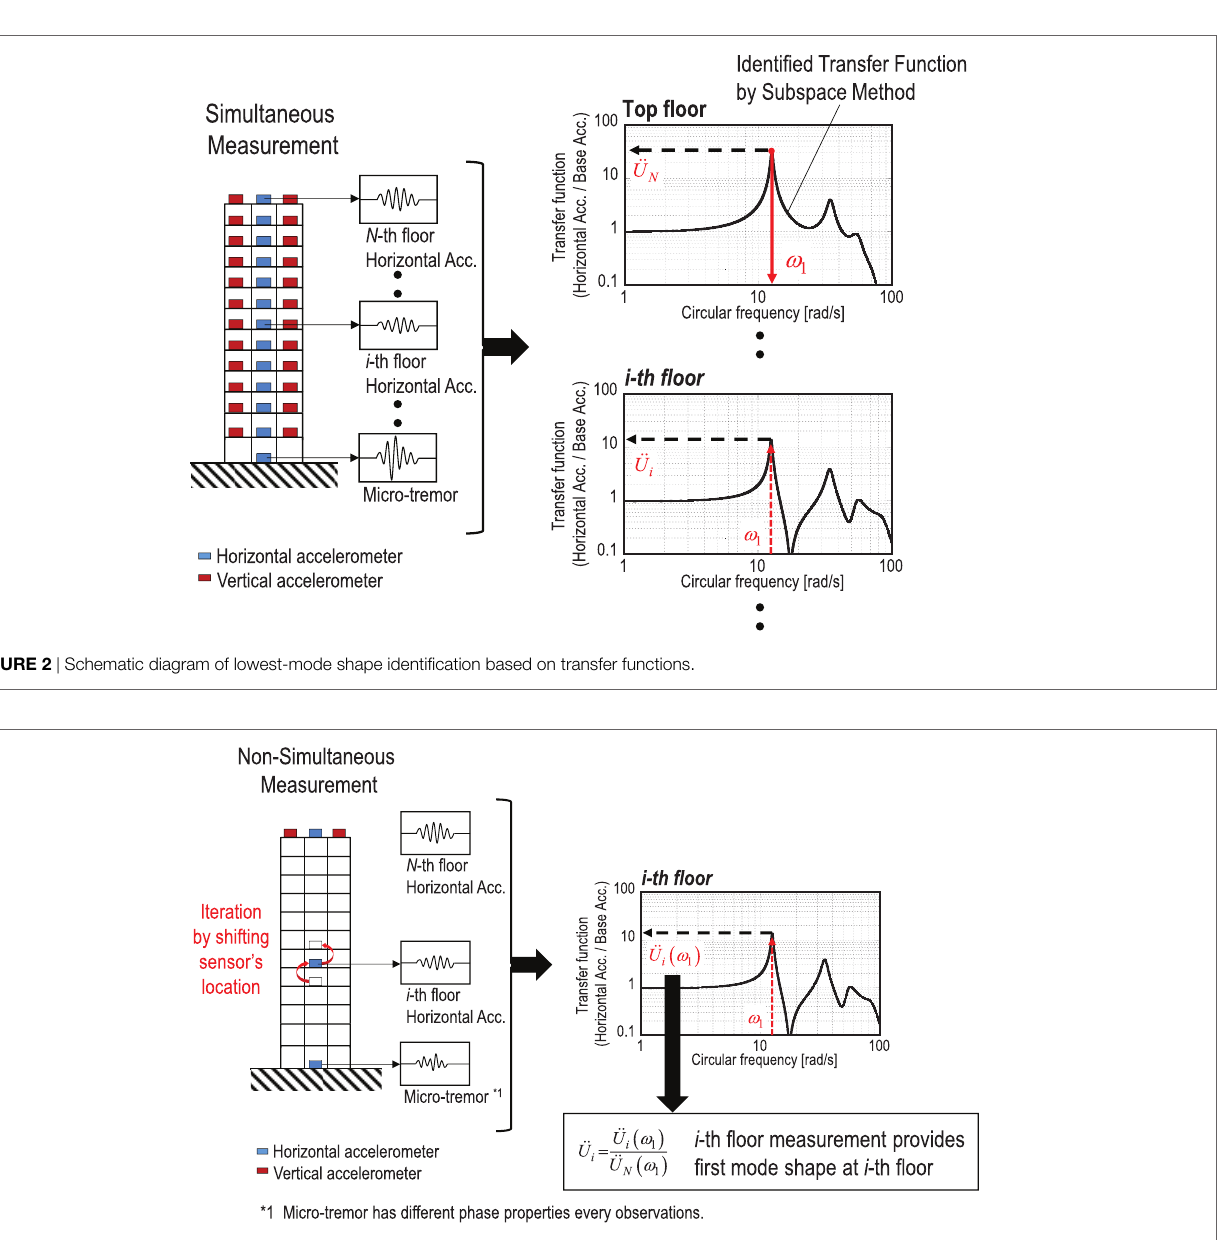
FIGURE 3 | Schematic diagram of lowest-mode shape identification in non-simultaneous measurement